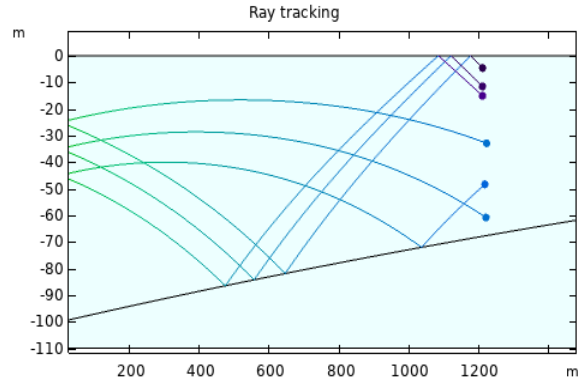
Figure 5. Ray trajectories at t = 0.5 s.